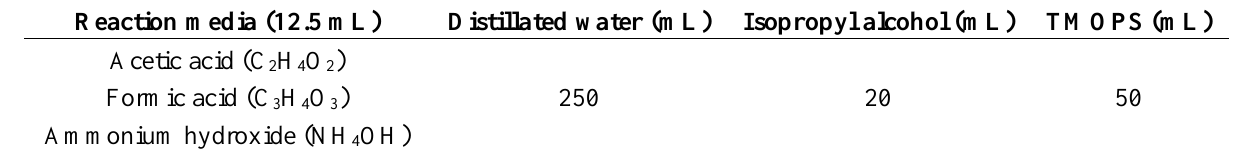
Table 1. Concentrations used for the synthesis of organosilanes samples trough sol-gel process. Reaction media (12.5